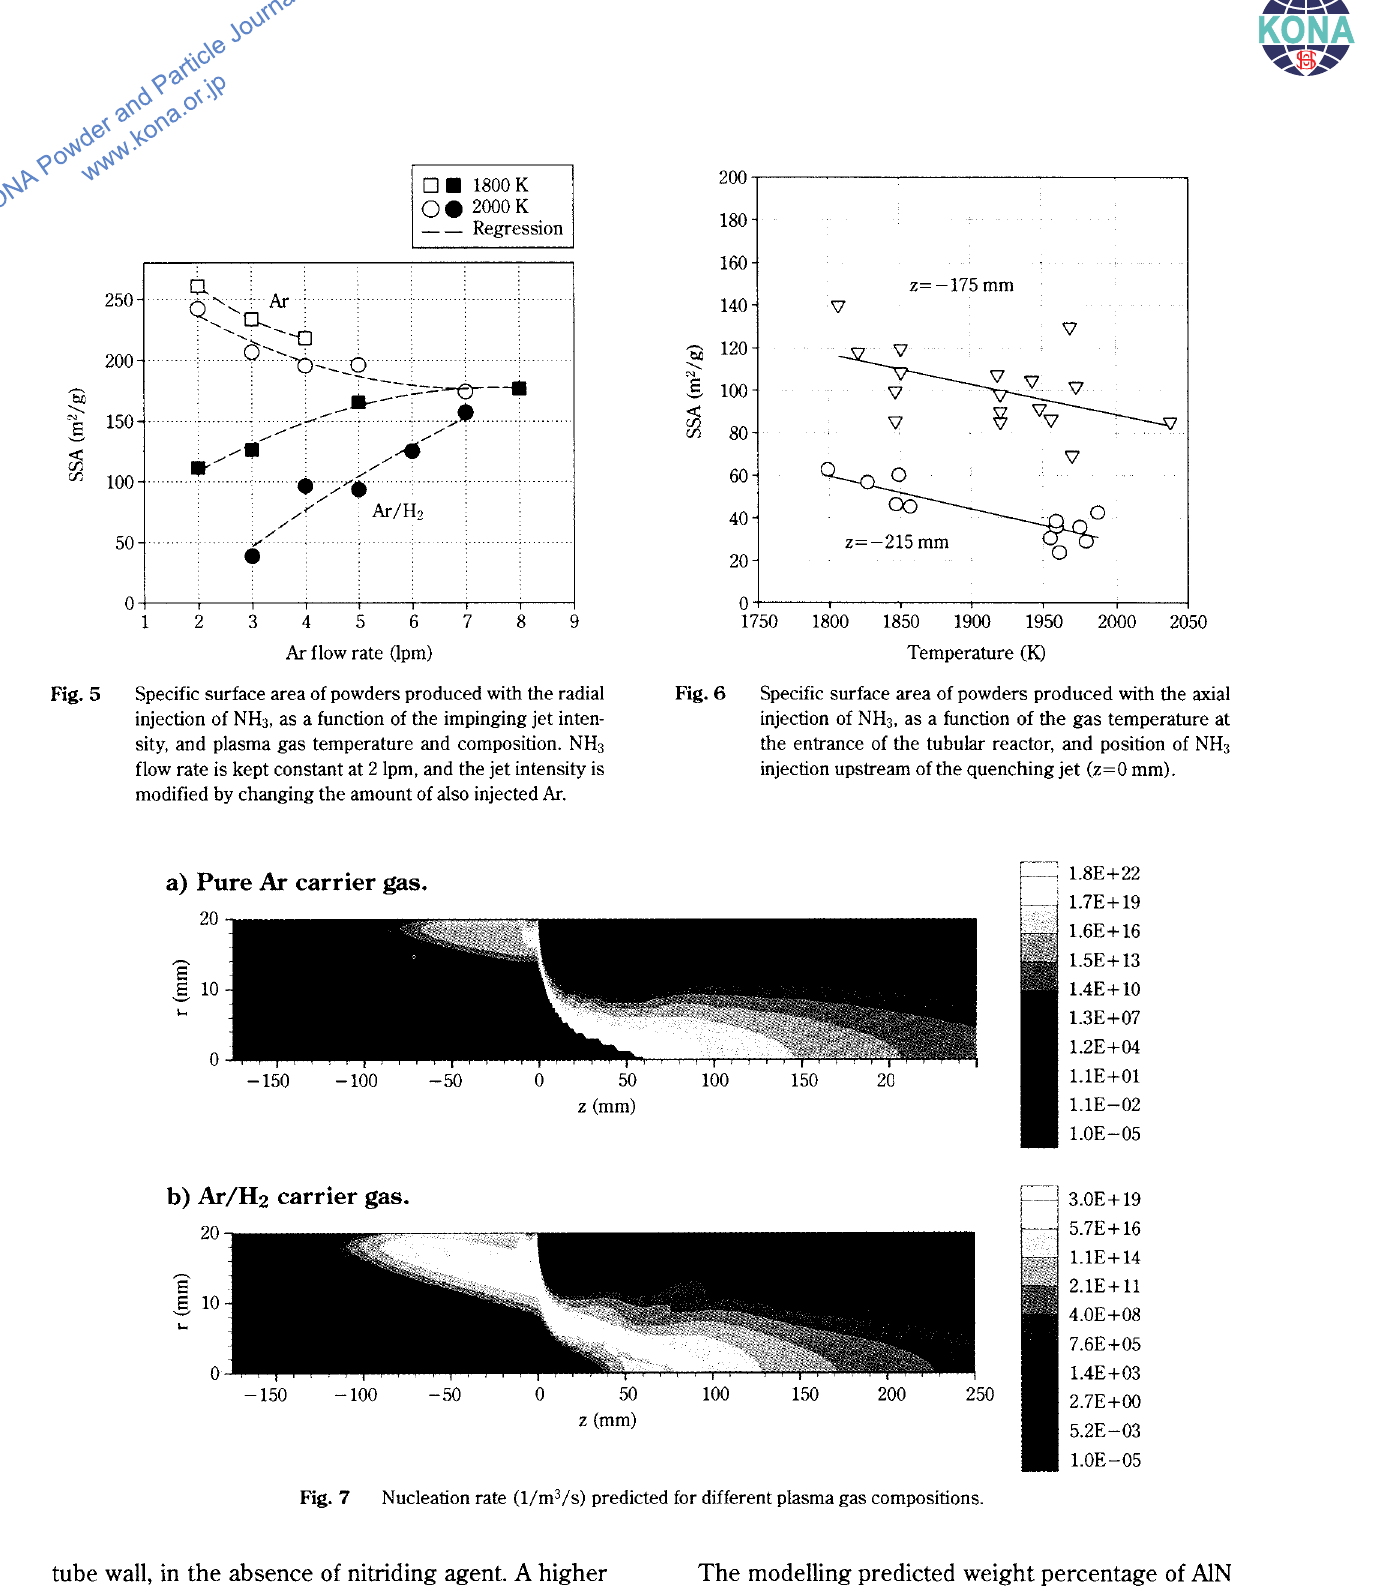
The modelling predicted weight percentage of AIN in the forming particles along the reaction zone for the radial and axial injection of ammonia of pure Ar plasma gas at 2000 K are shown in Figure 8 (a) and (b), respectively. Particles which nucleate near the wall upstream of the jet do so in total absence of NH 3 . Those particles which pass the injection point and remain near the wall where the NH concentration 3